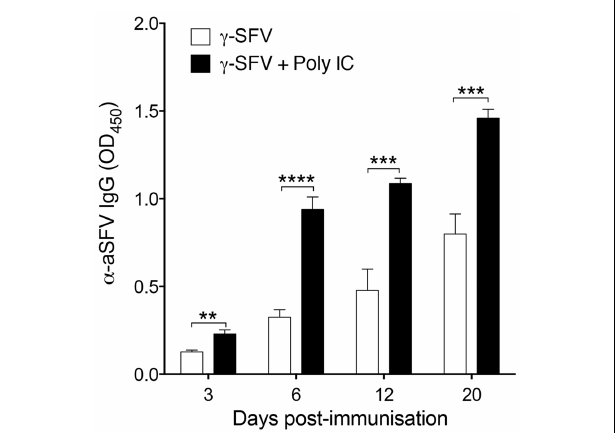
FIGURE 6 | Co-administration of Poly(I:C) and γ -SFV enhances SFV-specific IgG levels . Mice were vaccinated i.v. with γ -SFV (10 7 PFU equivalent/mouse) or co-injected with poly (I:C) (150 µ g).Total SFV-specific IgG levels in the serum were analyzed at day 3, 6, 12, and 20 post-vaccination using direct ELISA using a serum dilution of 1/200. Sera from naive mice served as negative controls. Results are presented as mean ± SEM ( n = 3) (*) denotes statistical significance, ** p < 0.01, *** p <